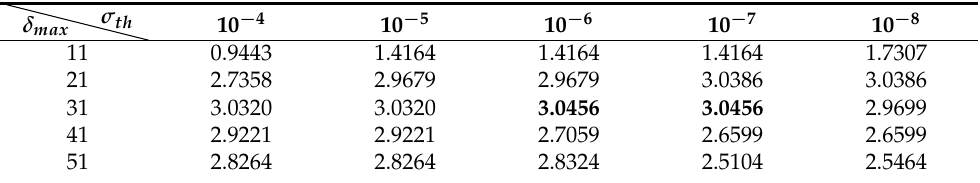
Table 6. The estimated multi-spectral fractal dimension (MFD) of the Pavia University multi-spectral image (right lower